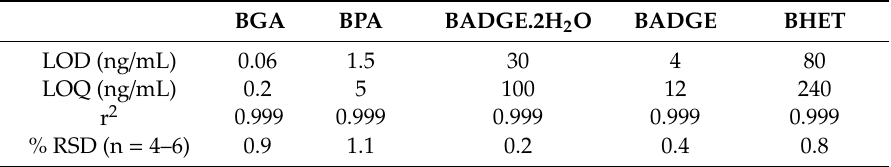
Table 5. Parameters of LOD, LOQ, correlation coe ffi cient, and repeatability of the studied compounds. BADGE.2H2O was detected at 225 nm while BADGE was detected at 232